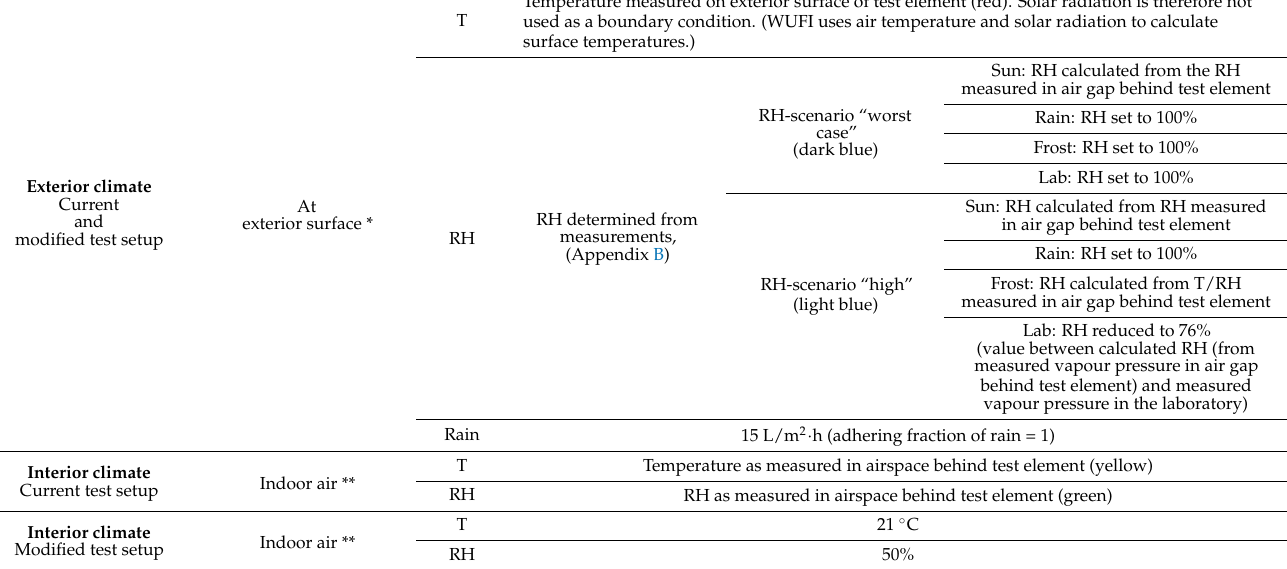
Table 2. Exterior and interior boundary conditions used in the hygrothermal simulations for the current and the modified test setups.